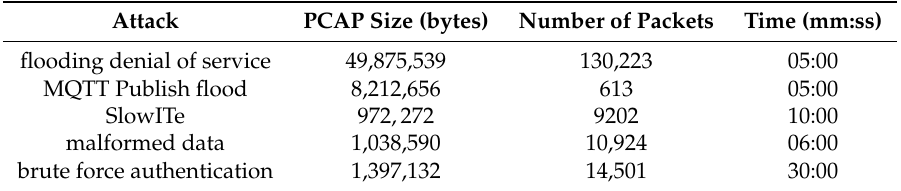
Table 3. Attacks executed in the